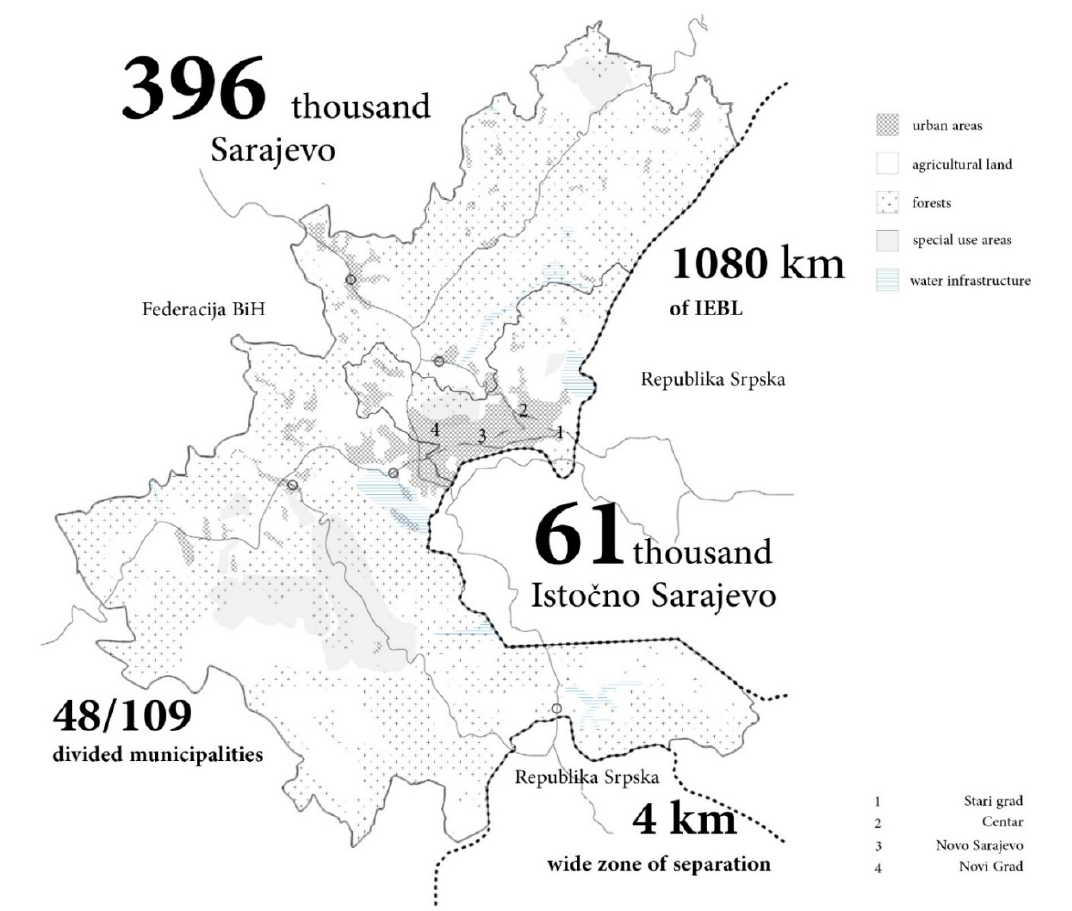
Figure 7: Canton Sarajevo showing the position of the IEBL, the populations of Sarajevo and East Sarajevo (Istočno Sarajevo), the number of municipalities divided by border and land